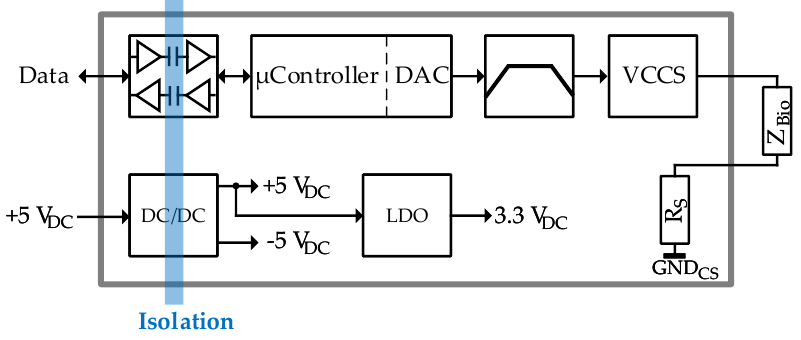
Figure 2. Block diagram of the developed decoupled current source module.